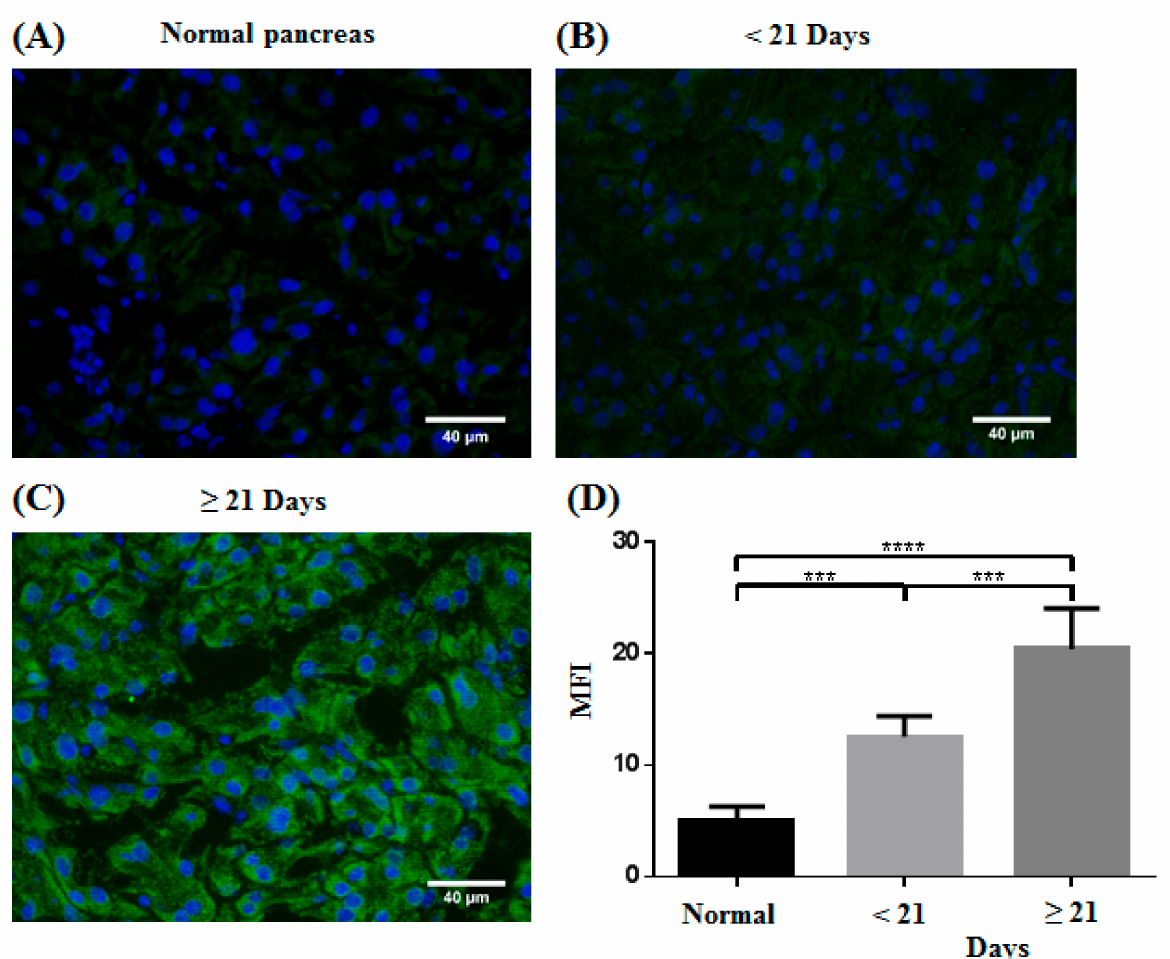
Figure 9. ( A – C ) Representative images of IHC staining for hypoxia using pimonidazole in the samples of normal pancreas and pancreatic tumors on various days after the tumor cell injection. The nucleus is presented in blue, and areas that stained positive for pimonidazole are shown in green. ( D ) Quantification of the MFI of pimonidazole staining. (n = 6 for normal pancreas, n = 5 for < 21 days, n = 4 for ≥ 21 days; *** p ≤ 0.001, **** p ≤